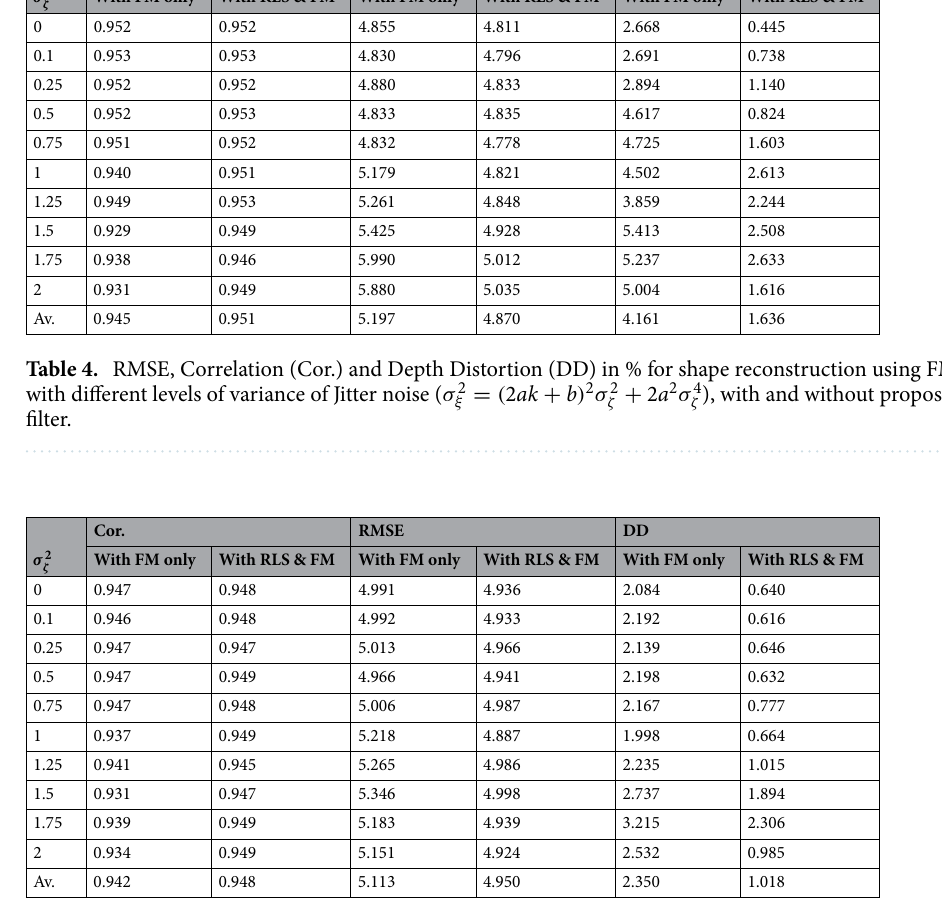
Table 5. RMSE, Correlation (Cor.) and Depth Distortion (DD) in % for shape reconstruction using FM:CONT with different levels of variance of Jitter noise ( σ 2 ξ = ( 2 ak + b ) 2 σ 2 ζ + 2 a 2 σ 4 ζ ), with and without proposed RLS filter.